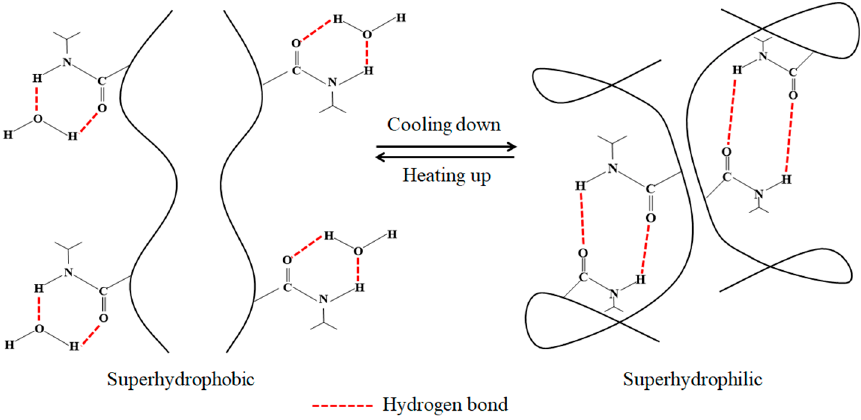
Figure 14. Mechanism of temperature response.